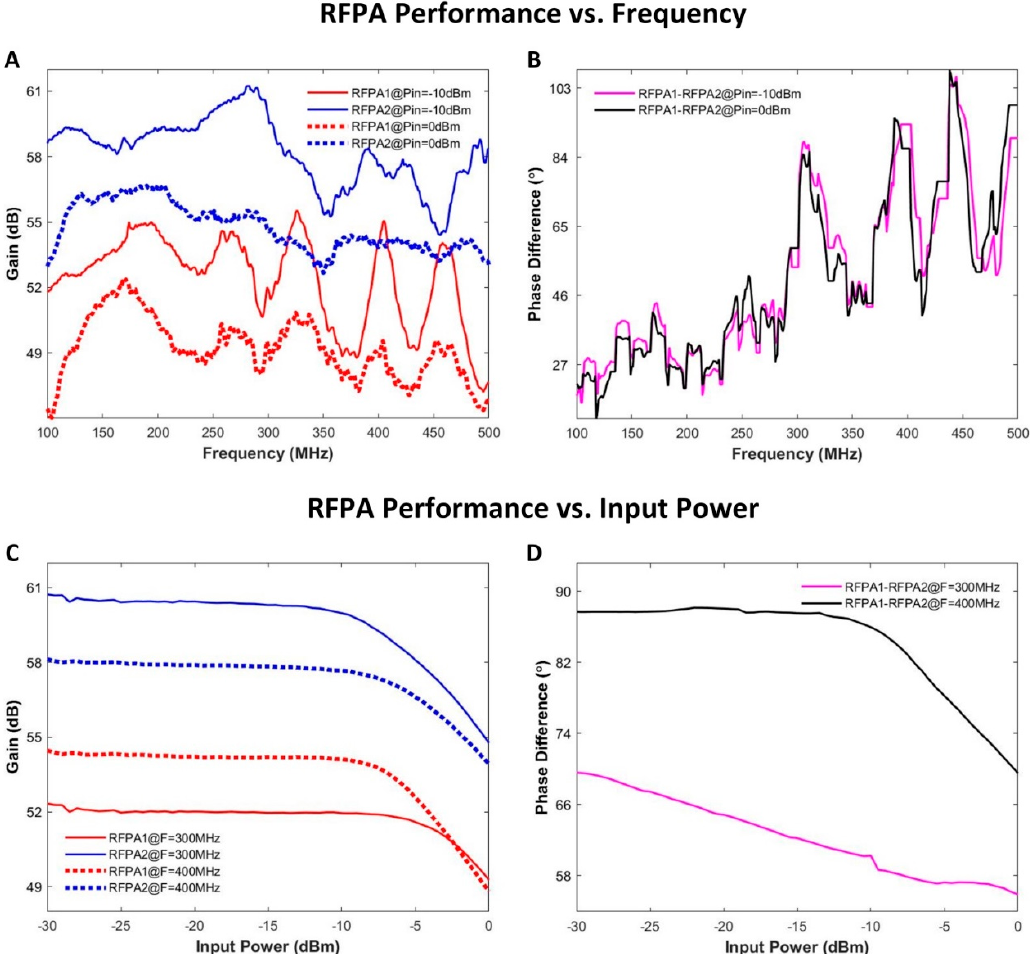
Figure 6. Summary of RFPA characterization results. ( A ) The gain of the two RFPAs was measured at two input levels ( − 10 and 0 dBm) for a frequency range of 100–500 MHz in increments of 1 MHz. ( B ) The phase difference between the outputs of the two RFPAs against frequency at different input power levels. ( C ) The gain of the two RFPAs was measured at two frequencies (300 and 400 MHz) with the input power level varying from − 30 to 0 dBm using an increment of 0.5 dBm. ( D ) The phase difference between the outputs of the two RFPAs against input power level at different